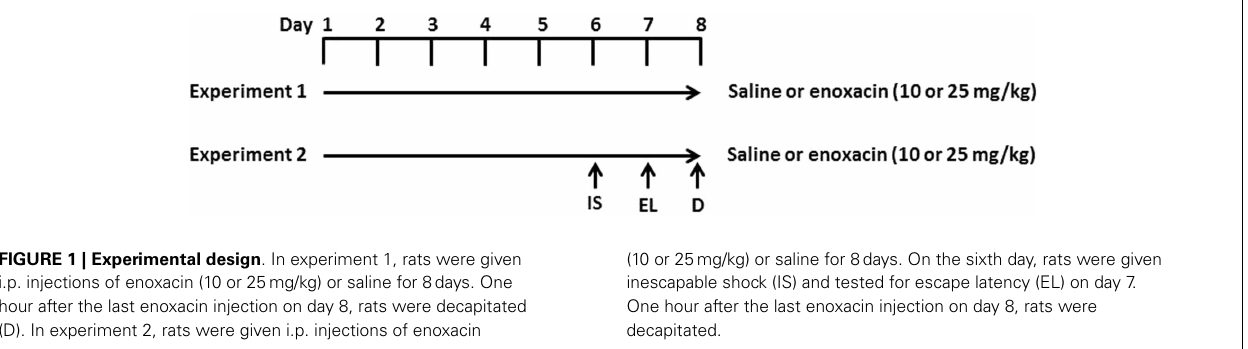
(10 or 25mg/kg) or saline for 8days. On the sixth day, rats were given inescapable shock (IS) and tested for escape latency (EL) on day 7. One hour after the last enoxacin injection on day 8, rats were